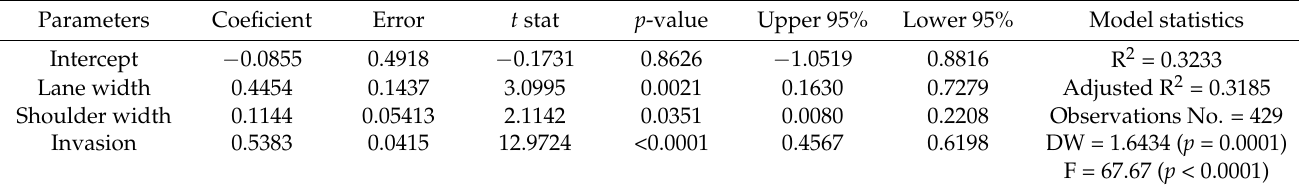
Table 4. Regression models for lateral clearance considering the different cyclist